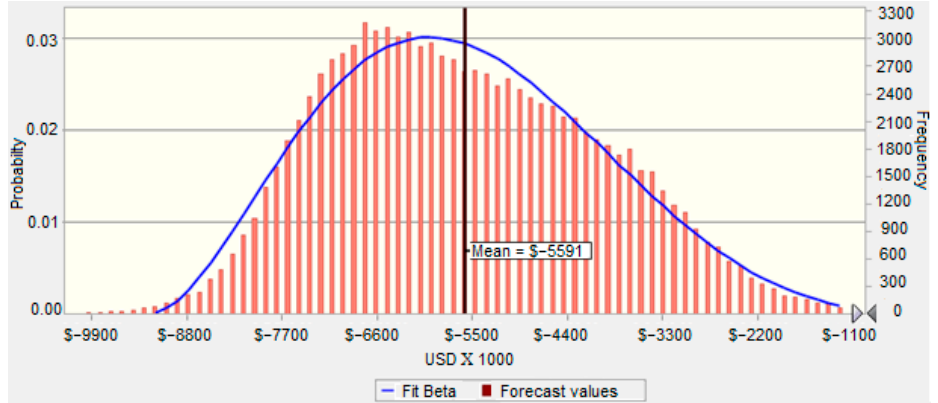
Figure 14. Prediction of NPV behavior for power system based on oxygen as a gasification agent.